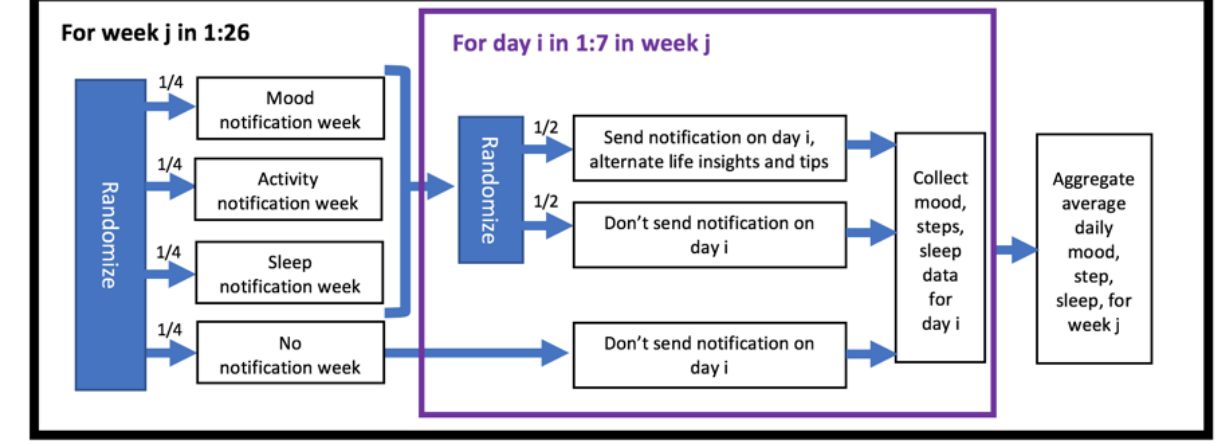
Figure 2. Randomization scheme of the Intern Health Study micro-randomized trial.